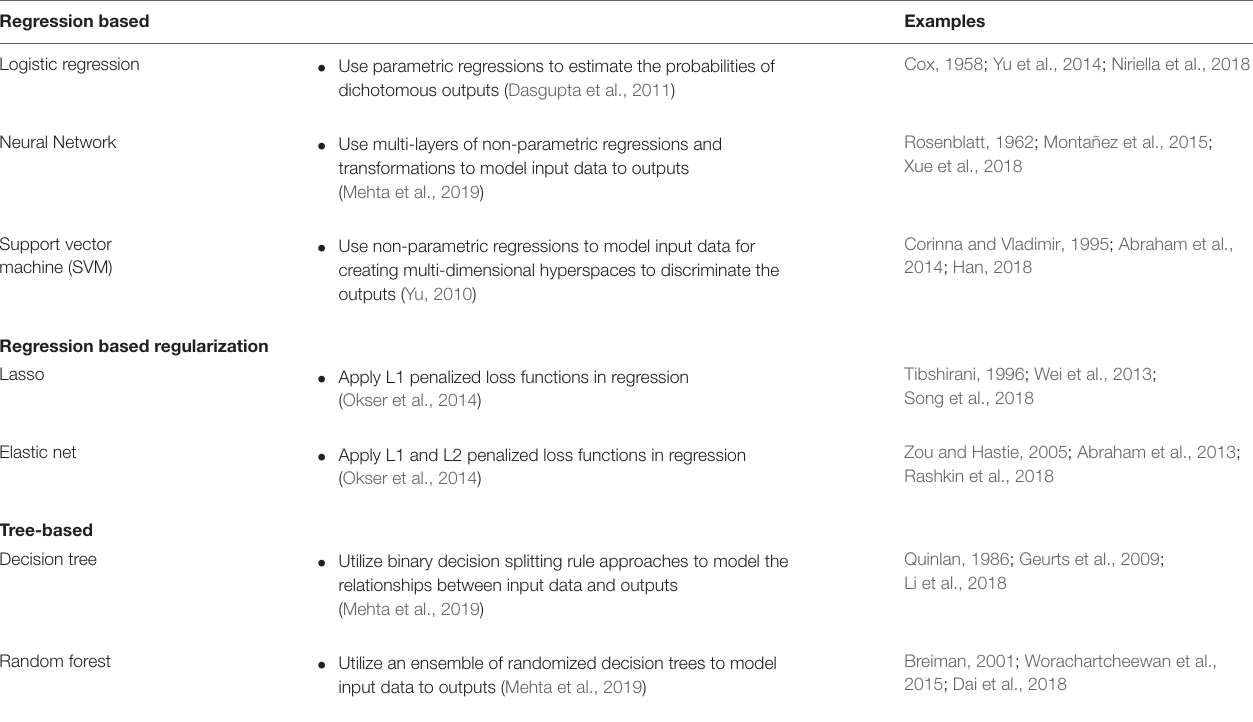
TABLE 1 | A brief view of common machine learning algorithms. Regression